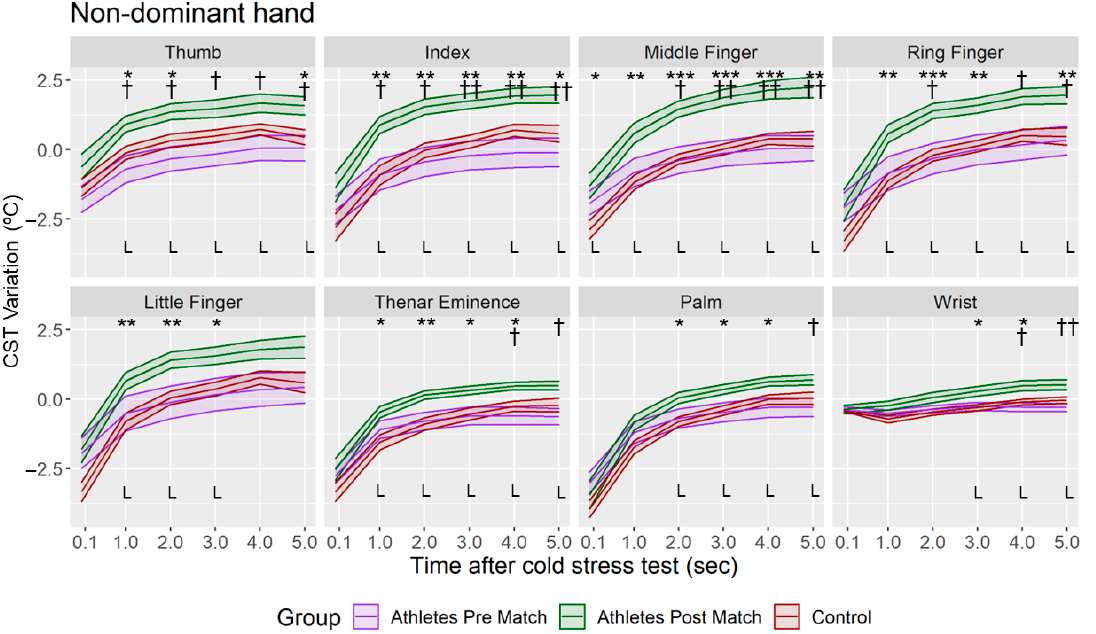
Figure 7. Mean and standard deviation of the CST variation in non-dominant hand for each minute after CST in all the groups. L = Large Effect Size. Difference between Athletes Group—Post Match and Athletes Group—Pre Match († p < 0.05; †† p < 0.01); Difference between Control Group and Athletes Group—Post Match (* p < 0.05; ** p < 0.01; *** p < 0.001).